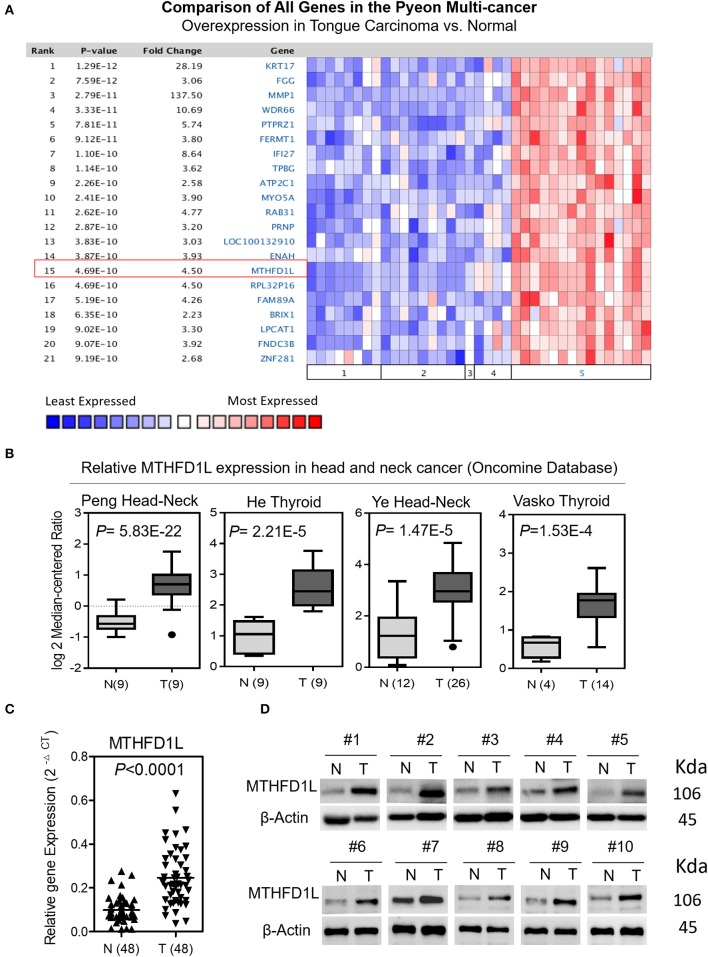
The expression of methylenetetrahydrofolate dehydrogenase 1-like (MTHFD1L) in TSCC. (A) Expression of various genes in the Oncomine TSCC database (1. Cervix Uteri; 2. Oral Cavity; 3. Palate; 4. Tonsil; 5. Tongue Carcinoma). (B) MTHFD1L expression in multiple Head and Neck cancers microarray data sets is available from the Oncomine database. (C) Real time quantitative polymerase chain reaction (qPCR) analysis of the MTHFD1L mRNA expression in 48 paired TSCC tissues. (D) Western blotting analysis of the MTHFD1L protein level in TSCC tissues and paired ANTs.